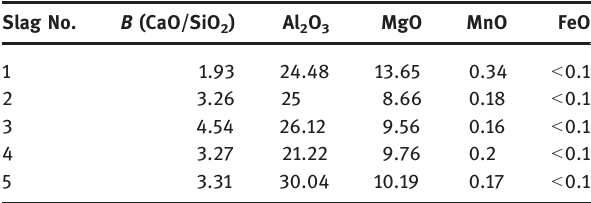
Table 5: Chemical composition of slag samples, mass%. Slag